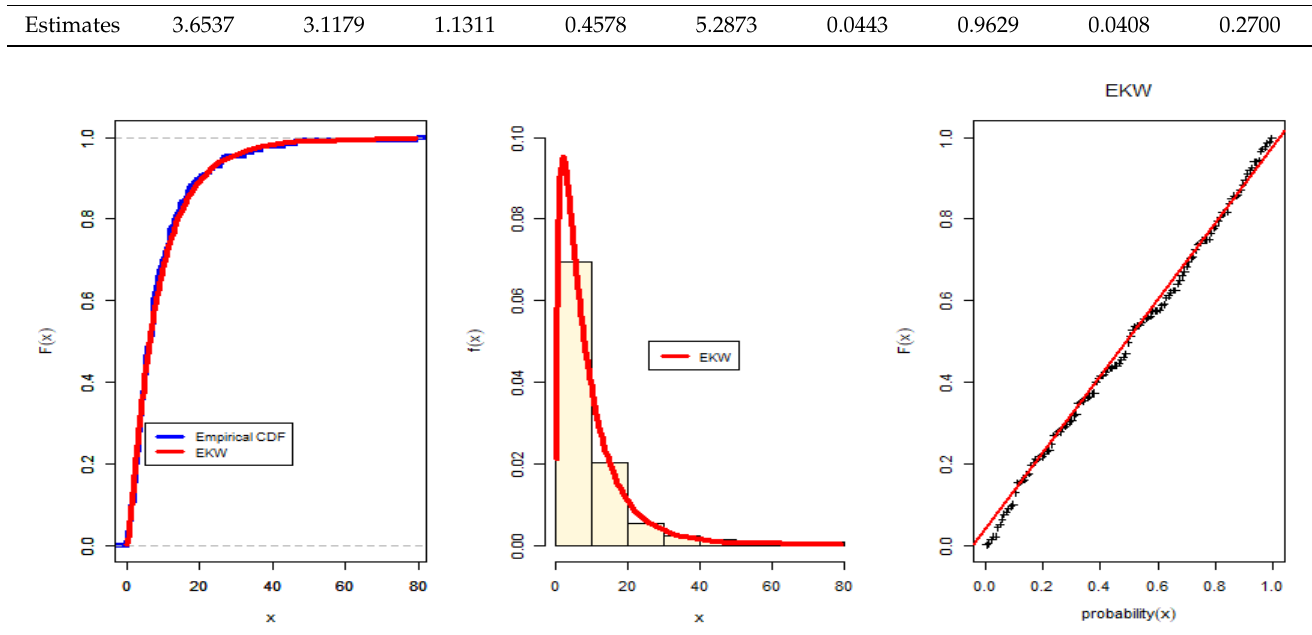
Figure 3. ML estimates of the EKW parameters for the complete bladder cancer data.